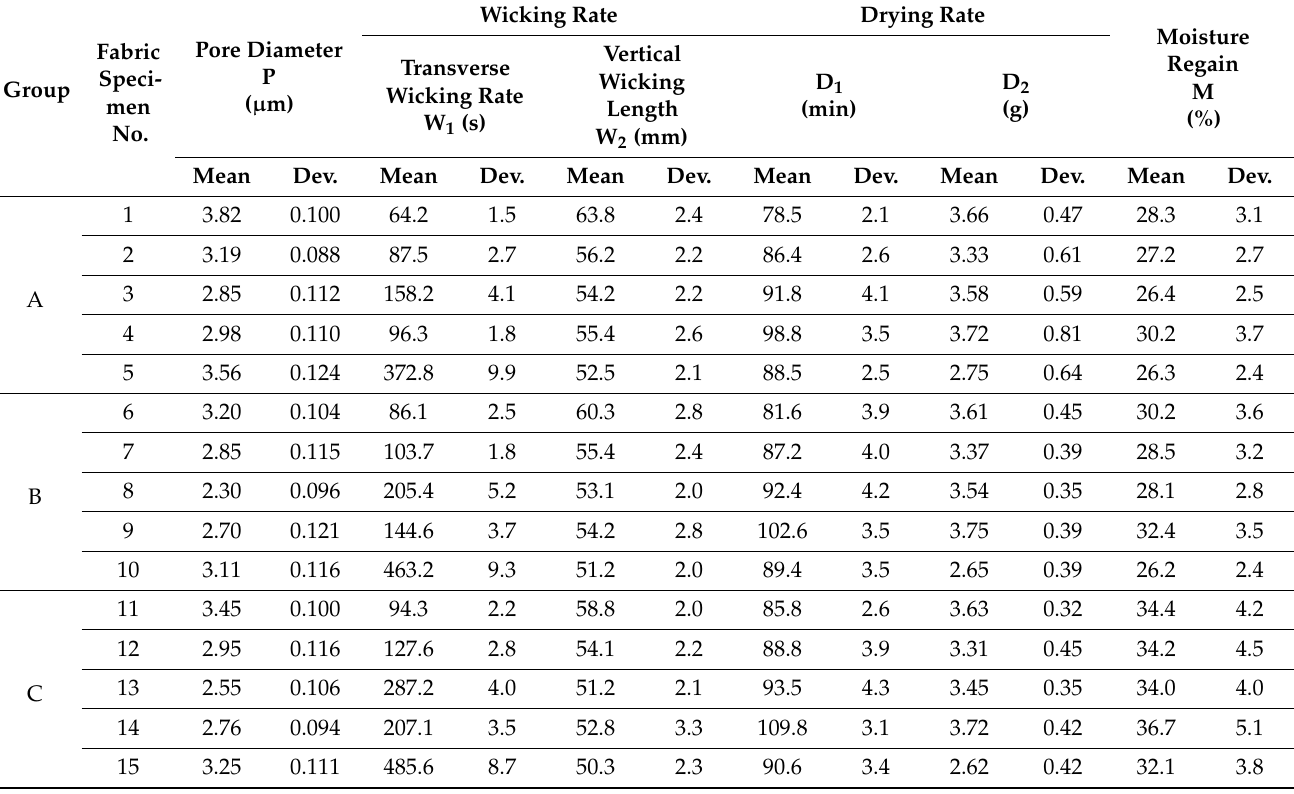
Table 3 lists the measured wicking and drying rates of the fabric specimens with different measured pore diameters. The deviation in Table 3 denotes the difference between the maximum and minimum values of the experimental data. Statistical analysis (F-test) was conducted to verify the statistical significance of the experimental data (Table 3). F-test to the difference of mean value between each specimen was conducted to verify the significance of the mean values of the four wicking and drying rates, including the pore diameter, with a 95% confidence limit (5% of significance level). The mean value of the specimens of each group for the pore diameter ( µ m) was statistically significant, as F 0 (V/Ve) > F(4, 20, 0.95) and p < 0.05. Table 3. Pore size, wicking and drying rate of three fabric